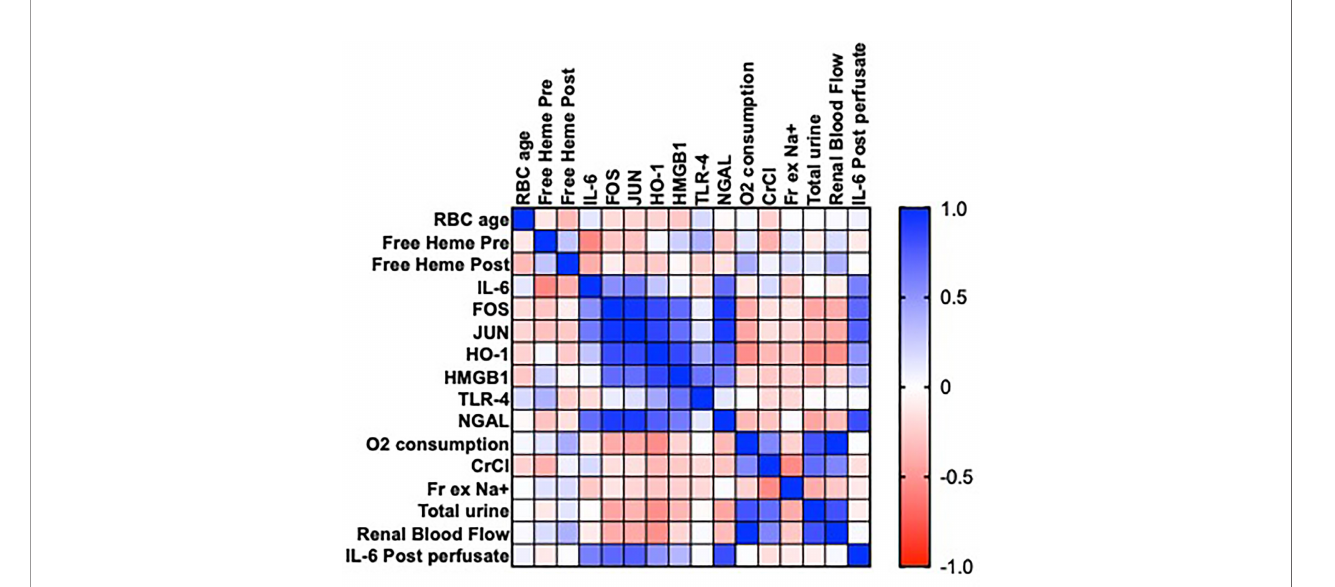
FIGURE 4 | Heatmap showing Pearson ’ s correlation matrix in a series of 15 human kidneys rejected for transplantation to examine the associations of the age of packed red blood cells (pRBC) and levels of free heme on gene expression (IL-6, FOS, JUN, HO-1, HMGB1 and TLR-4) after NMP, measures of renal function (oxygen consumption, creatinine clearance [CrCl], fractional excretion of sodium [Fr Ex Na+], total urine output, renal blood fl ow), levels of urinary neutrophil gelatinase associated lipocalin (NGAL) and perfusate levels of IL-6 post NMP. Values are